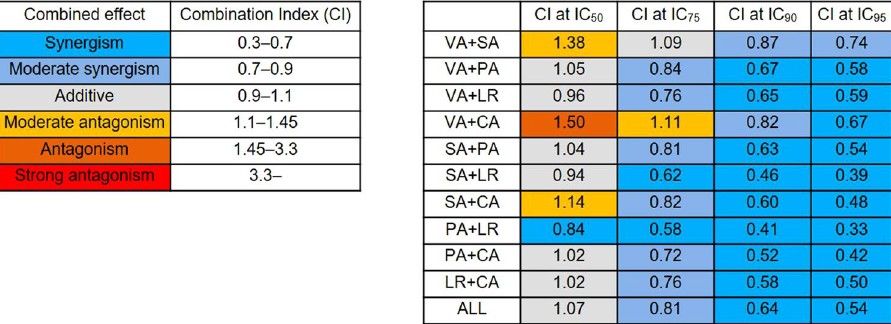
Figure 6. Combination index estimated from the combined effect of all active compounds on antigen- induced degranulation of RBL-2H3 cells. The effects of active compounds were tested in pairs (e.g., VA + SA). The two compounds were mixed at equal molar concentrations and the inhibitory effect of the mixture on β -hexosaminidase release was examined. The combination index (CI) at IC 50 , IC 75 , IC 90 and IC 95 was estimated from the β -hexosaminidase release inhibition rate. ALL: includes all five active compounds (VA + SA + PA + LR + CA). The combined effect was defined as follows: CI < 0.7, synergism; 0.7 ≤ CI ≤ 0.9, moderate synergism; 0.9 < CI < 1.1, additive effect; 1.1 ≤ CI ≤ 1.45, moderate antagonism; 1.45 < CI < 3.3, antagonism; 3.3 ≤ CI, strong antagonism. The evaluation criteria of the combined effect are listed and